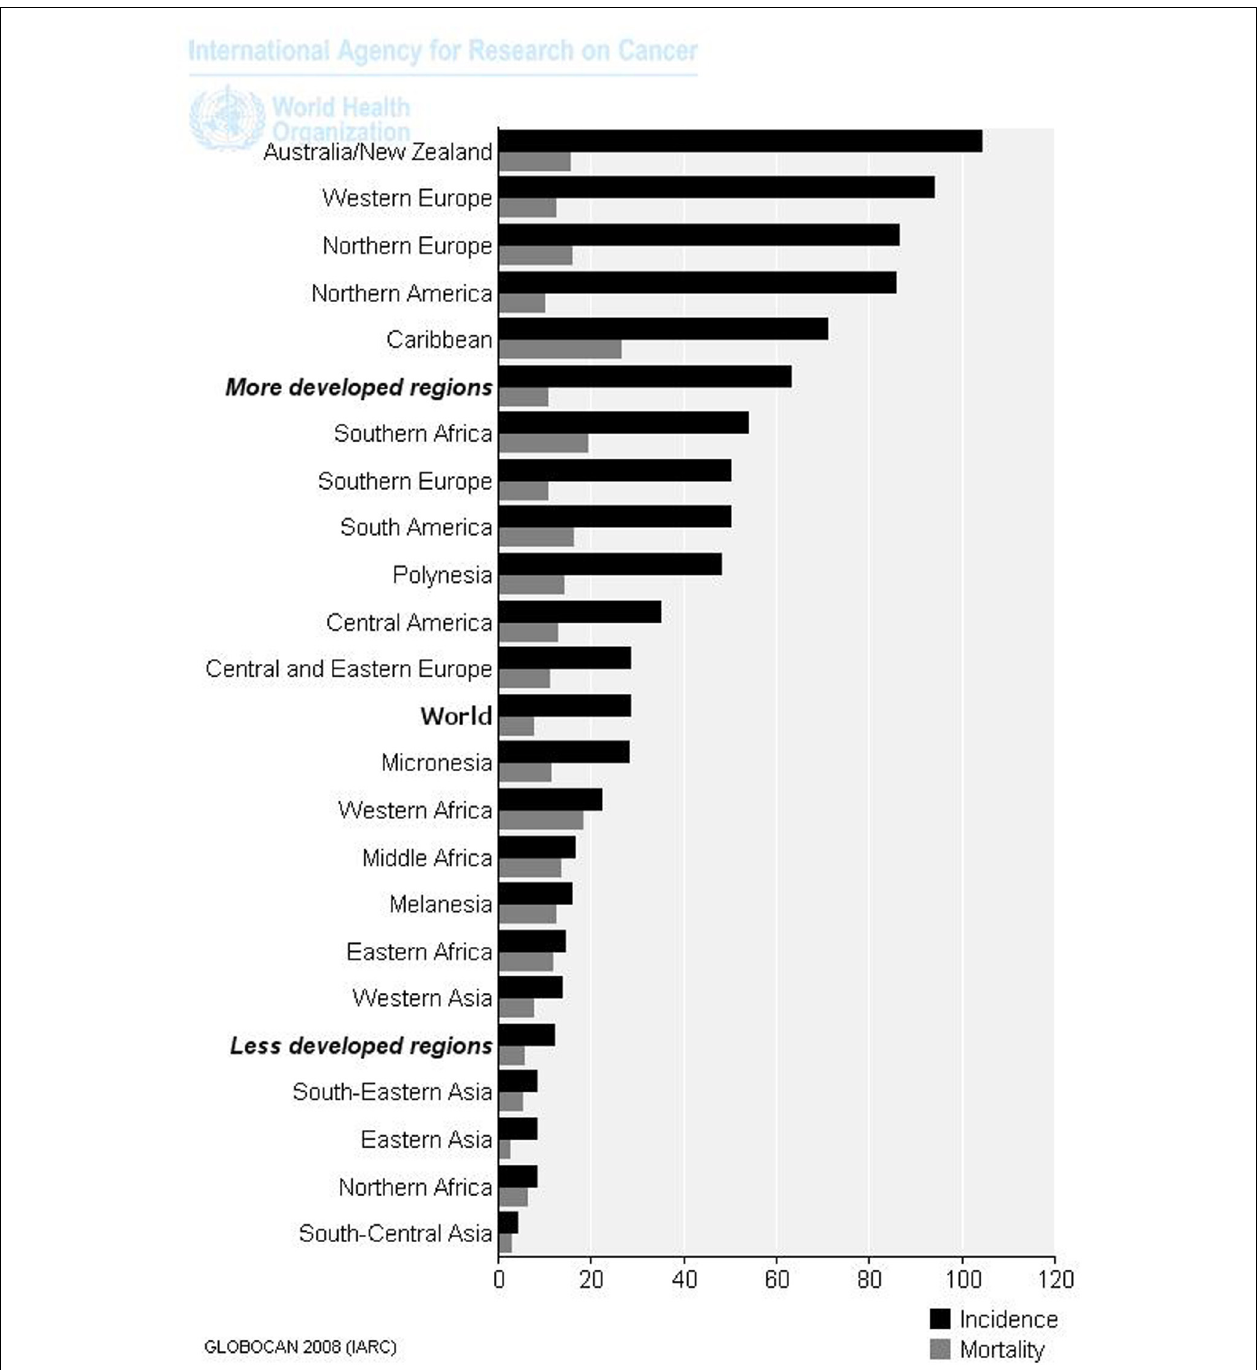
FIGURE 1 |Age-standardized rates (world) per 100,000 of PC in 2008 (data from Ferlay etal.,